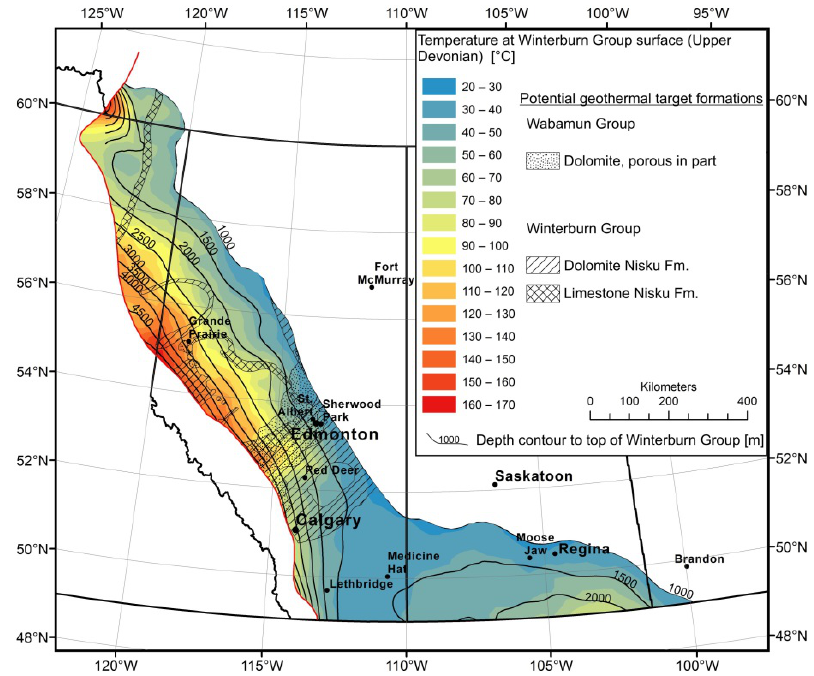
Figure 7. Temperature at the top of the Winterburn Group; formations outline from Switzer et al. [29] (Winterburn Group) and from Halbertsma [32] (Wabamun Group).